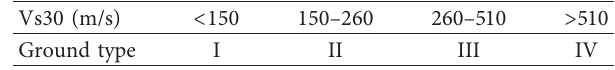
Table 1: The average shear wave velocity (Vs30).